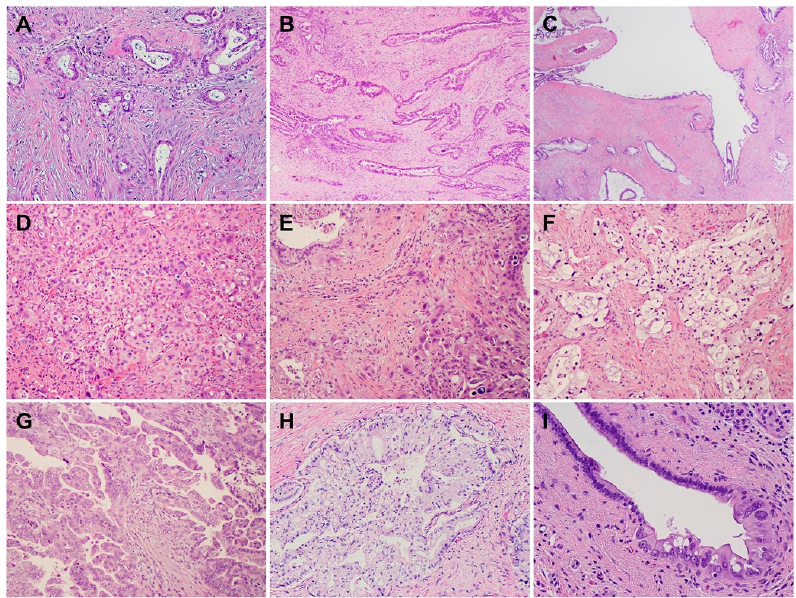
Figure 1. Pancreatic ductal adenocarcinomas (PDACs) with various histomorphological patterns (hematoxylin and eosin stain). ( A ) Moderately differentiated PDAC with extensive desmoplastic stroma; ( B ) moderately differentiated PDAC with interconnecting complex glands embedded in desmoplastic stroma; ( C ) large duct variant of PDAC; ( D ) poorly differentiated PDAC; ( E ) poorly differentiated PDAC intermixed with moderately differentiated areas; ( F ) clear cell variant of PDAC; ( G ) moderately differentiated PDAC showing extensive, complex intra-luminal micropapillary for- mation; ( H ) cribriform histology with foamy cells; ( I ) pagetoid involvement of pancreatic duct by PDAC (intra-ductal